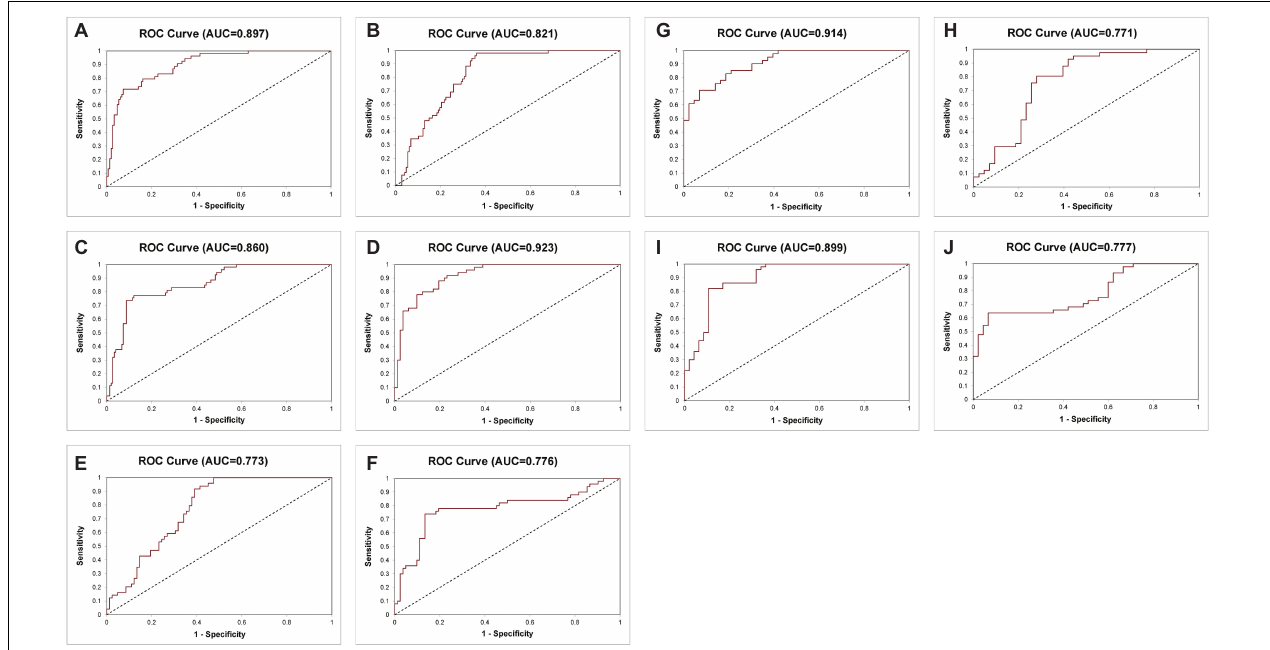
FIGURE 3 | Receiver operating characteristic curves of the 14-Gene Panel, serum prostate-specific antigen (PSA) and Gleason score for diagnosis of higher-risk and lower-risk PCa. ROC curve of the 14-Gene Panel (A) , PSA (B) , and Gleason score (C) in the prospective PCa urine cohort ( n = 202). ROC curve of the 14-Gene Panel (D) , PSA (E) , and Gleason score (F) in patients with Gleason scores 6 and 7 in the prospective PCa urine cohort ( n = 132). ROC curve of the 14-Gene Panel (G) and PSA (H) in patients with Gleason score 7 in the prospective PCa urine cohort ( n = 84). ROC curve of the 14-Gene Panel (I) and Gleason score (J) in the retrospective PCa urine cohort ( n =